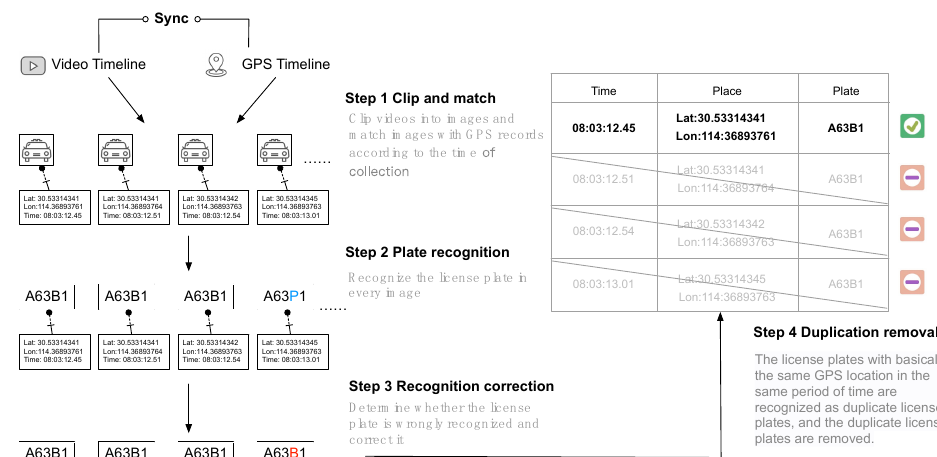
Figure 3. Parking data preprocess. First, videos collected by the self-designed app are clipped into frames to match the GPS records according to the collection time. Second, license plates in every frame are recognized. Then, rules are set to identify whether a certain license plate is erroneously recognized and correct the error. Finally, duplicated license plate records that have the same license plate, GPS location, and collection time are removed.